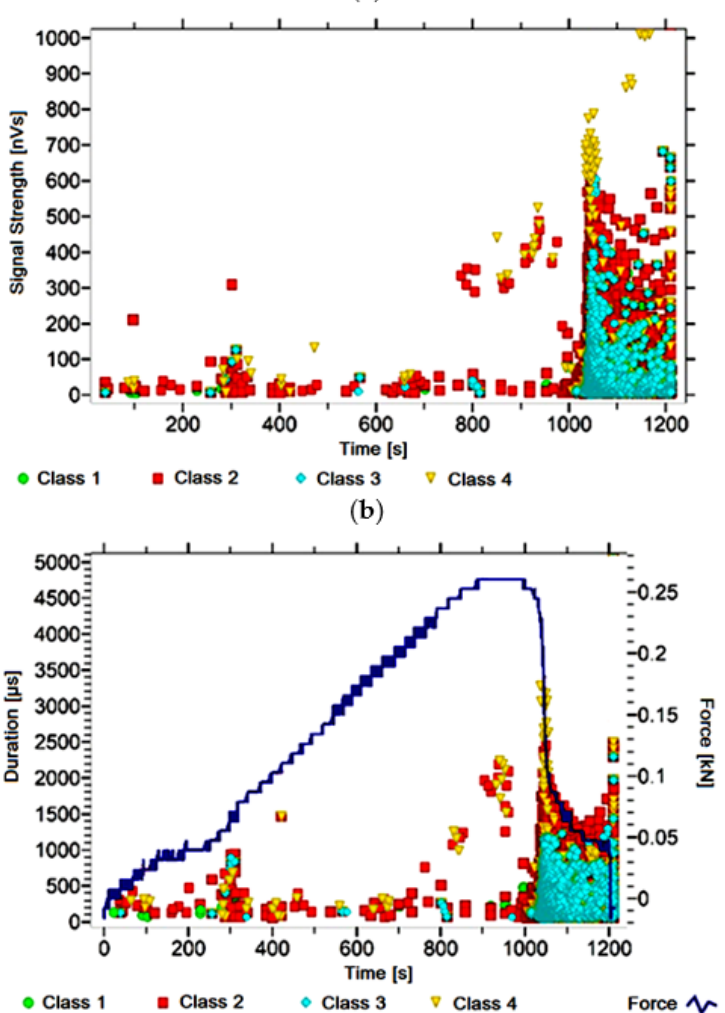
Figure 4. Graphs of acoustic emission signals for an exemplary sample of A 3 series: ( a ) signal strength over time; ( b ) distribution of the duration of the signals over time with the force increment curve.